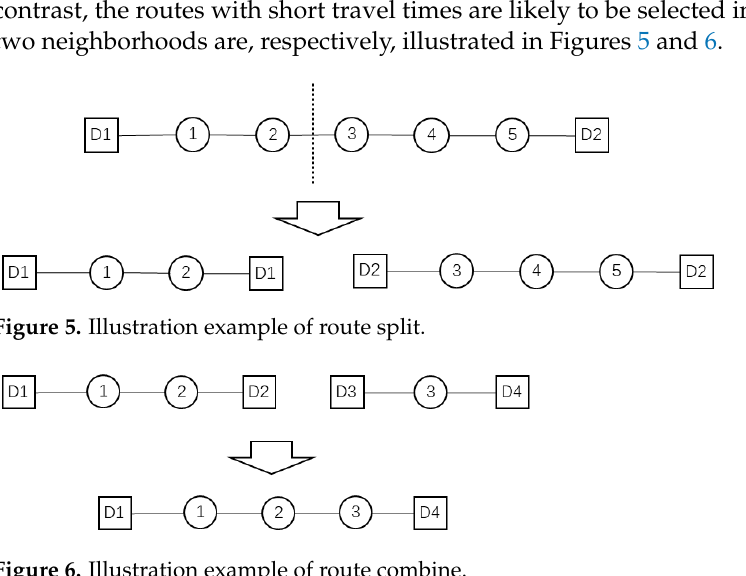
Figure 4. Illustration example of depot change.